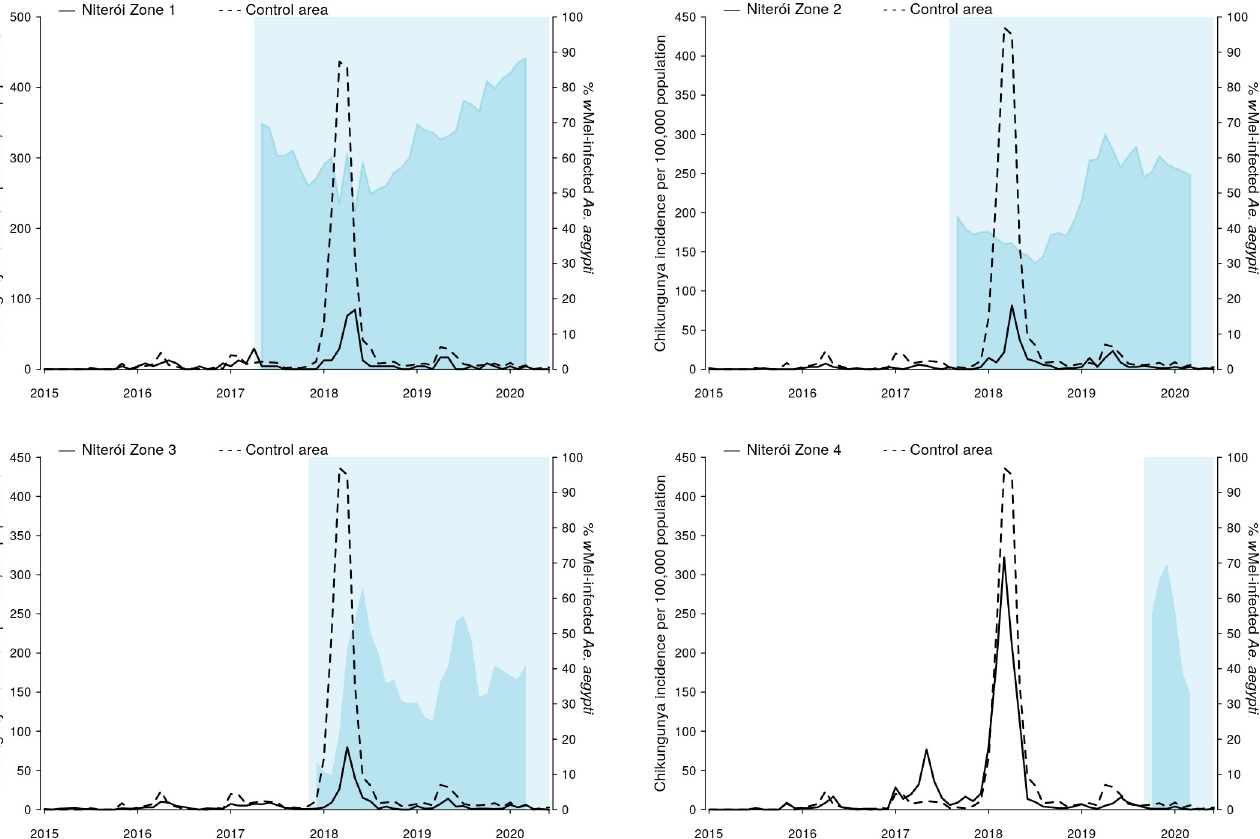
Fig 5. Chikungunya incidence and w Mel infection prevalence in local Aedes aegypti mosquito populations, by release zone. Lines show the monthly incidence of chikungunya case notifications per 100,000 population (left-hand Y axis) in Nitero ´ i release zones 1–4 (solid line in each panel) compared with the untreated control zone (dashed line), January 2015—June 2020. Light blue shading indicates the beginning of the epidemiological monitoring period in each zone, one month after initial releases were completed in each respective zone. Darker blue shading indicates the aggregate w Mel infection prevalence (right- hand Y axis) in each zone in each calendar month from the start of the epidemiological monitoring period until March 2020 (no w Mel monitoring April—June 2020).